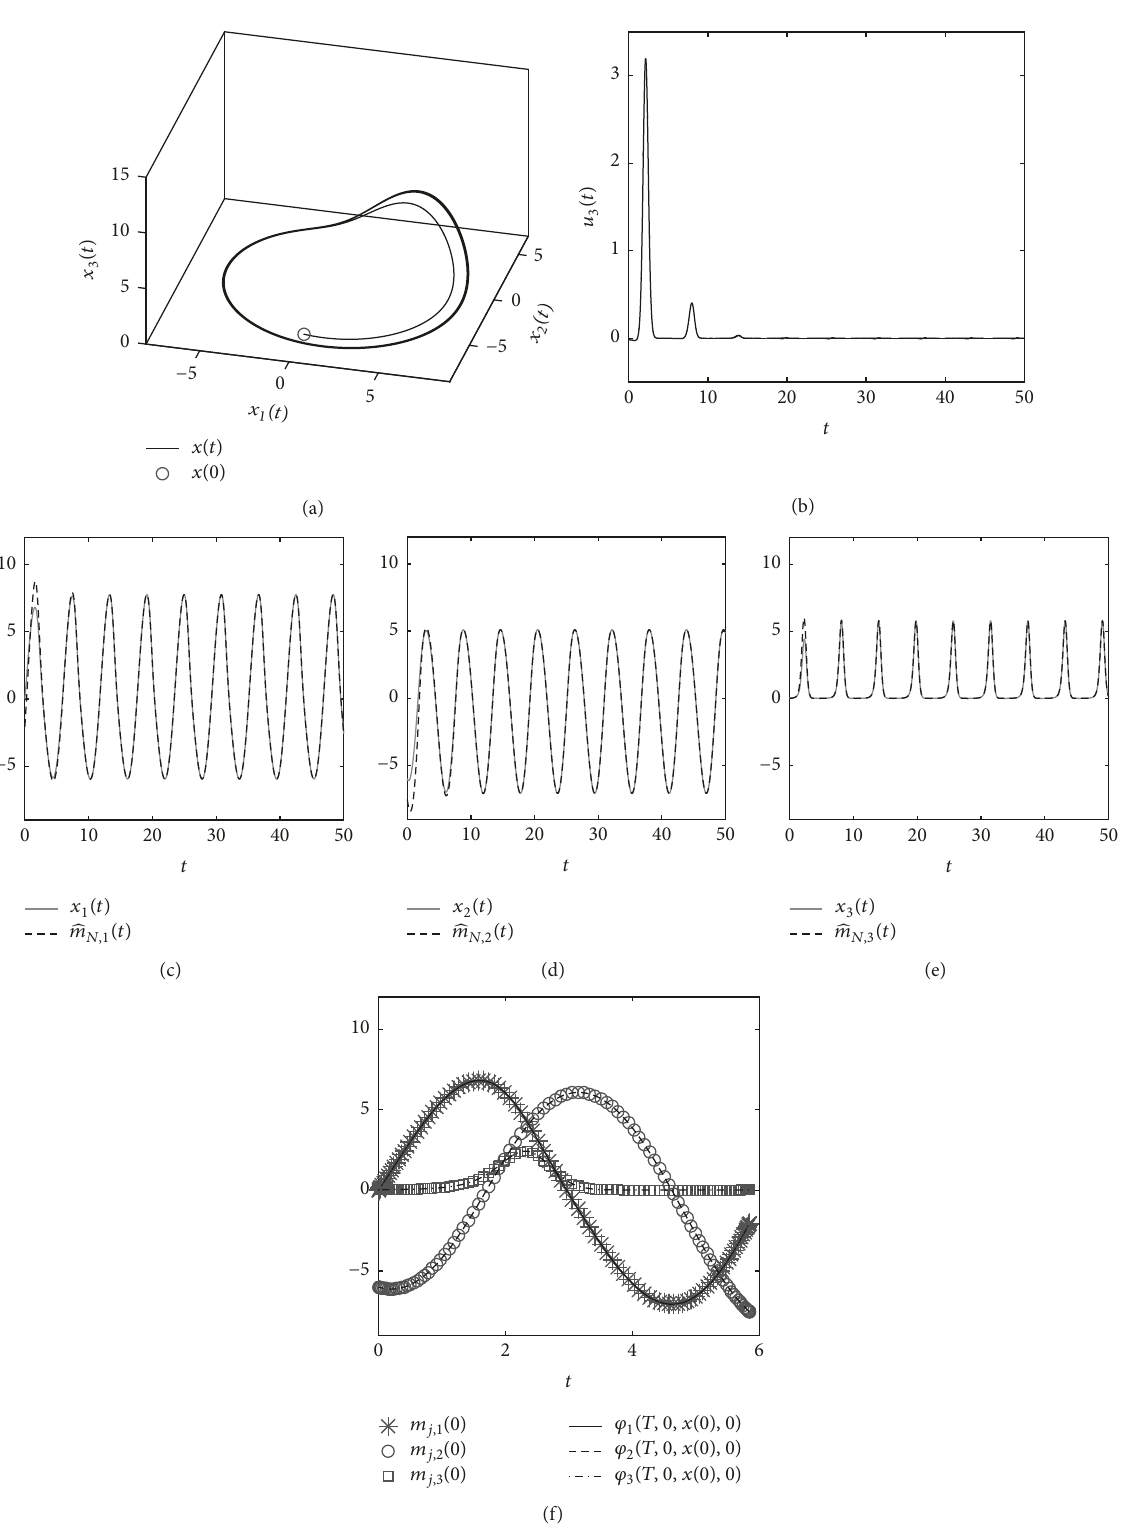
Figure 22: aPBC applied to the R¨ossler system with 𝑁 = 102 , 𝑘 = 1.85 , and 𝑘 𝑜 = 10 . (a) Trajectory in state space; (b) time-series of the control signal; ((c), (d), and (e)) time-series of the actual and predicted state variables; (f) time-series of 𝜑(𝑇,0,𝑥(0),0) and the initial value of the predicted states 𝑚 𝑗 (0)